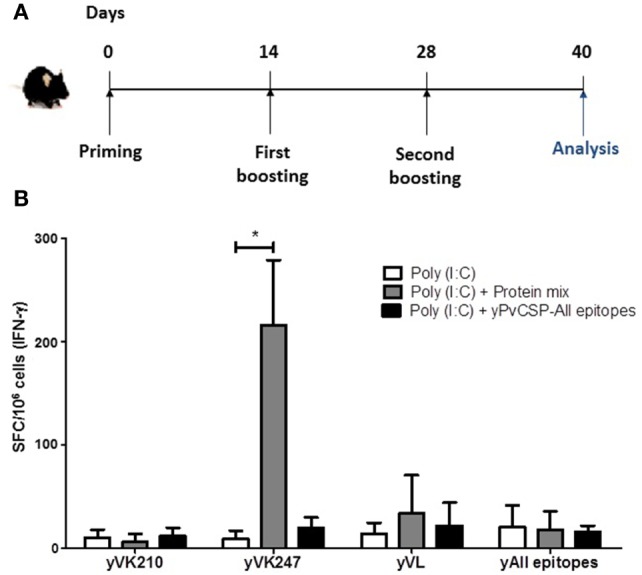
Interferon gamma (IFN-γ)-producing cells in mice immunized with recombinant proteins. (A) C57BL/6 mice were immunized following the scheme with yPvCSP-All epitopes (3 μg/mouse) or a mix of yPvCSP-VK210 + yPvCSP-VK247 + yPvCSP-P. vivax-like (1 μg/each protein/mouse), in the presence of the adjuvant Poly(I:C). (B) To measure the number of cells secreting IFN-γ, splenocytes collected from immunized C57BL/6 mice on day 40 after priming were used for enzyme-linked immunospot (ELISPOT) assays. The recombinant proteins yPvCSP-VK210 (yVK210), yPvCSP-VK247 (yVK247), yPvCSP-P. vivax-like (yVL), and yPvCS-All epitopes (yAll epitopes) were used as stimuli (10 µg/mL). SFC, spot forming cells. Asterisk denotes statistical differences (P < 0.05).